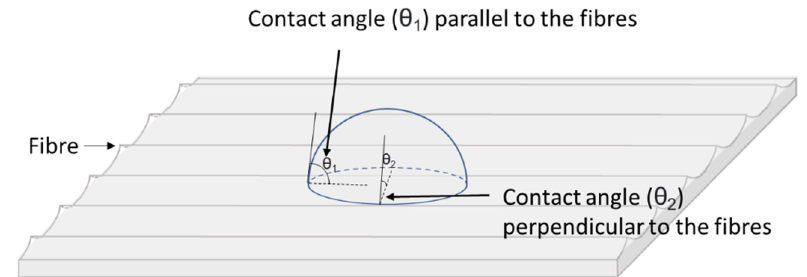
Figure 9. Schematic diagram of water contact angles measured parallel or perpendicular to the orientation of the fibres.